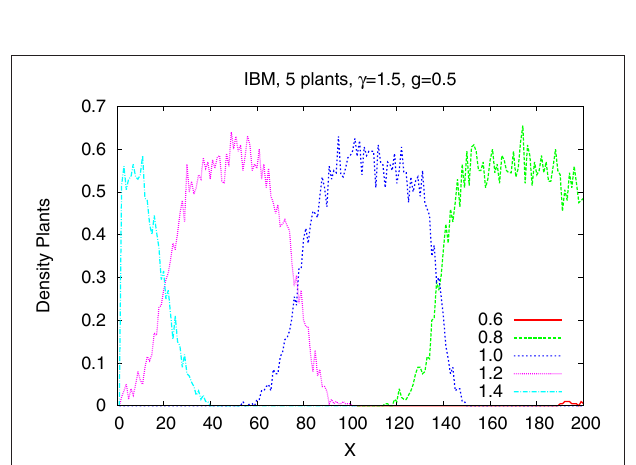
FIGURE 6 | Density of plants of five types along the gradient. γ IBM approach.